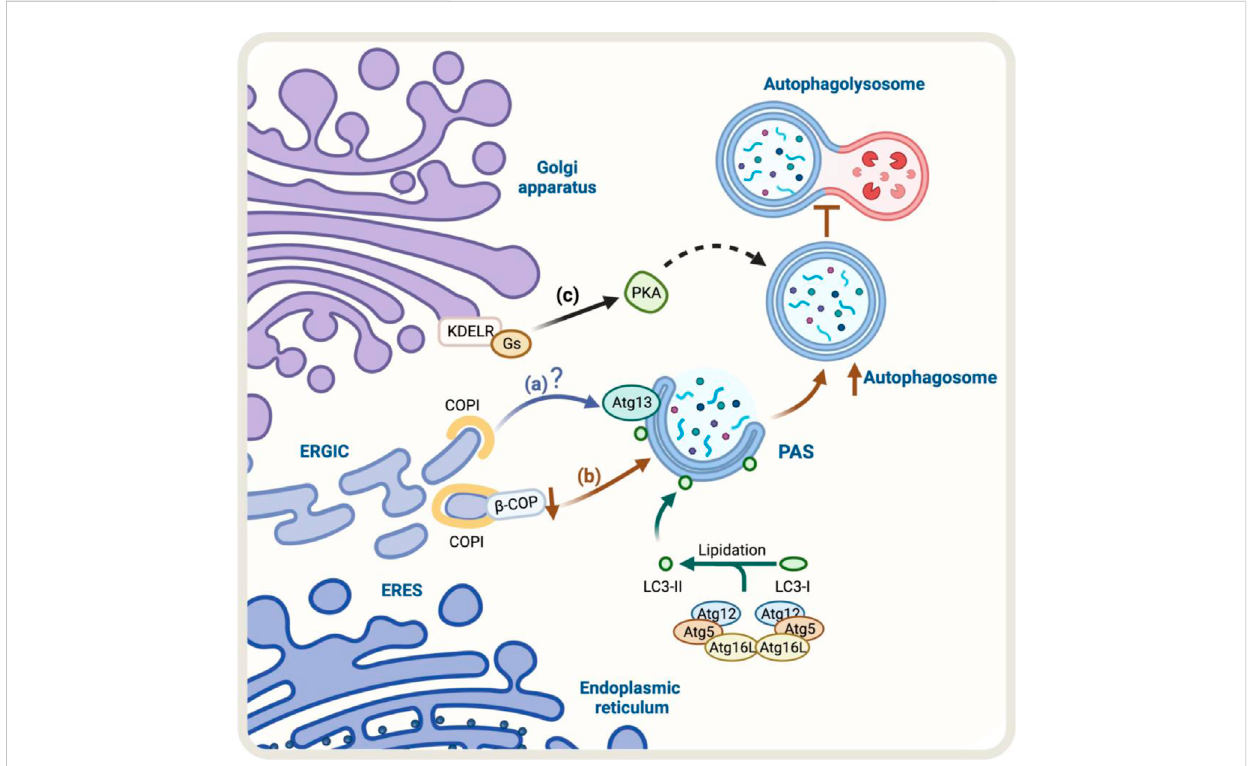
FIGURE 2 SchematicrepresentationoftheregulatorsofGolgi-to-ERretrogradepathwayandautophagy. (A) Understarvationconditions,COPIlocalizesatthe ERGIC. COPI-mediated traf fi cking may recruit Atg13, however, the molecular mechanism is still unclear (blue arrow). (B) The knock-down of β -COP, a proteinoftheCOPIcomplex,resultsinanaccumulationofautophagosomalstructures.Still,italsopartiallyhindersthefusionoftheautophagosomewith the lysosome and the degradation and recycling process (brown arrows) (C) KDEL/Gs signaling pathway, which includes PKA activation, may be involved in the upregulation of autophagy (black arrows). The green arrow represents the process of lipidation of LC3 protein by Atgs proteins that is necessary for substrate recognition and autophagosome